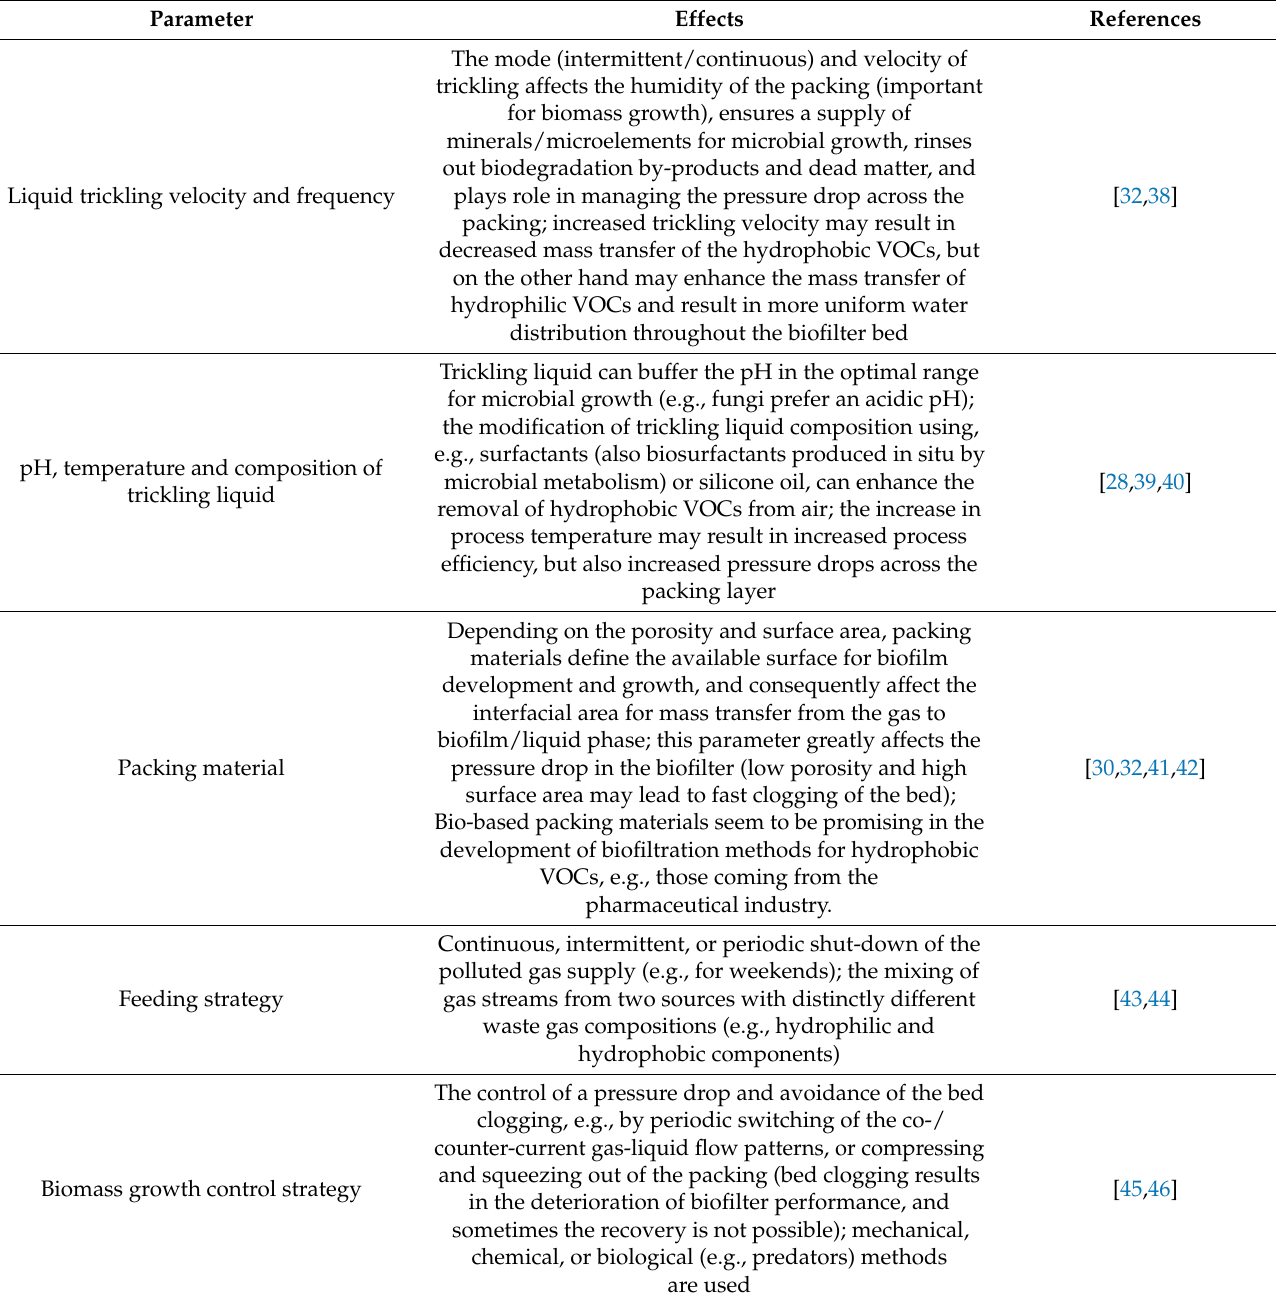
Table 1. Selected operating and process parameters and their effects of the performance of biotrickling filters treating air polluted with